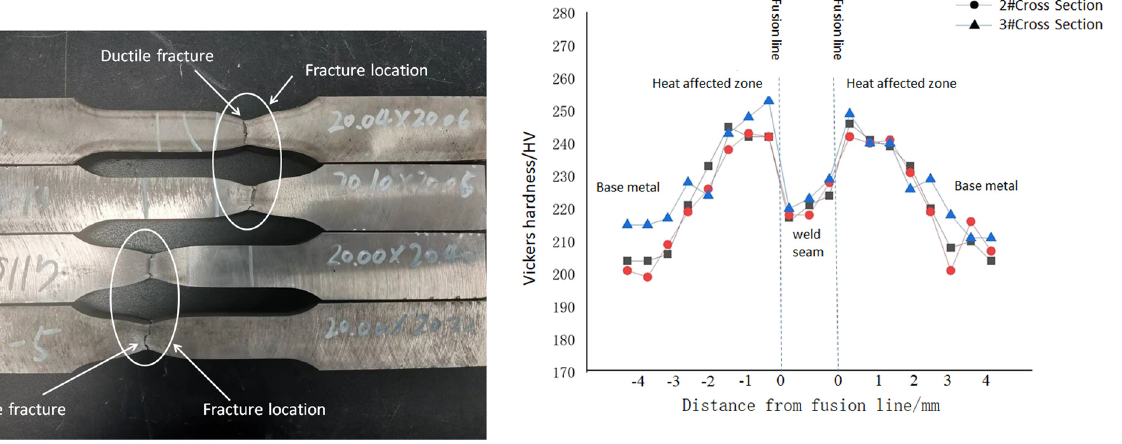
Figure 7: 1 – 3# Vickers hardness in di ff erent areas of Welded joint